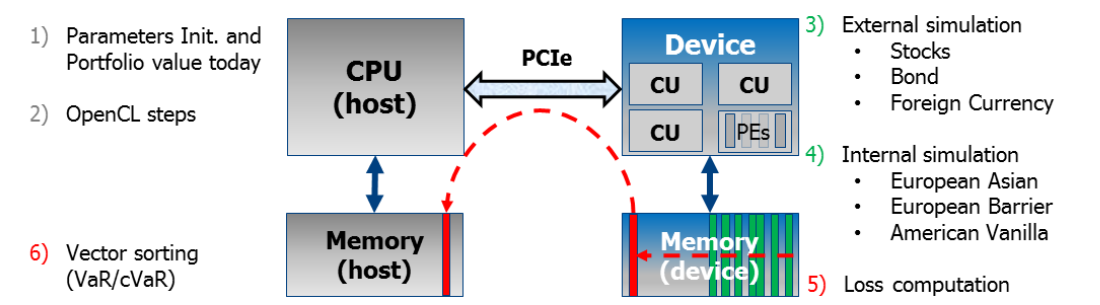
Figure 4. Sequence of steps for our full portfolio VaR/cVaR project.